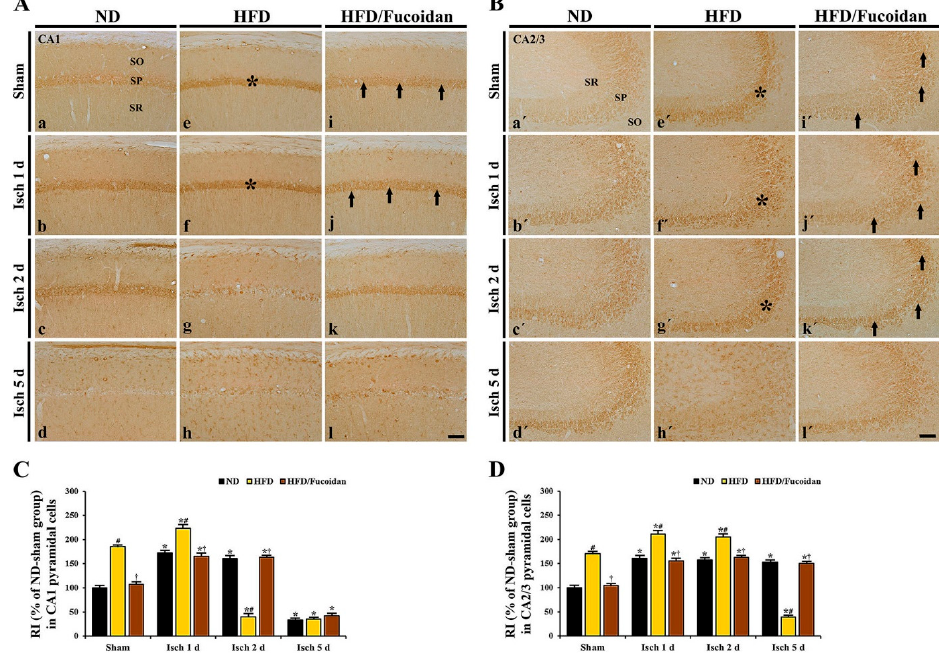
Figure 6. ( A , B ) 4-HNE immunohistochemistry in the CA1 ( A ) and CA2/3 ( B ) areas of the ND-fed (left columns), HFD-fed (middle columns) and HFD/Fucoidan-fed (right columns) groups at sham (a, e i, a (cid:48) , e (cid:48) , i (cid:48) ), 1 day (b, f, j, b (cid:48) , f (cid:48) , j (cid:48) ), 2 days (c, g, k, c (cid:48) , g (cid:48) , k (cid:48) ) and 5 days (d, h, l, d (cid:48) , h (cid:48) , l (cid:48) ) after tGCI. Asterisks show that 4-HNE immunoreactivity in CA1-3 pyramidal cells is significantly increased in the HFD-sham and ischemia groups. Arrows indicate that 4-HNE immunoreactivity in CA1-3 pyramidal cells is deceased in the HFD/Fucoidan-fed group compared to the HFD-fed group. Scale bar = 60 µ m. ( C , D ) Quantitative analysis of 4-HNE immunoreactivity in the CA1 ( C ) and CA2/3 ( D ) pyramidal cells ( n = 7/group). The bars indicate the means ± SEM. * P < 0.05 vs. each sham group, # P < 0.05 vs. ND-fed group, † P < 0.05 vs. HFD-fed group.